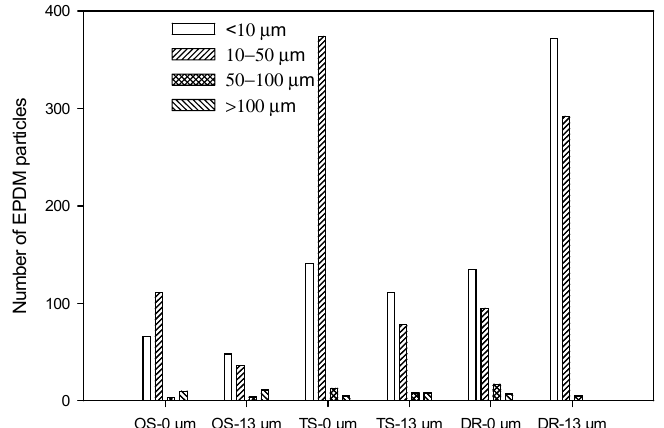
Figure 20. Analysis of the EPDM particle number in PP/EPDM 75/25 blends using different meth- ods.